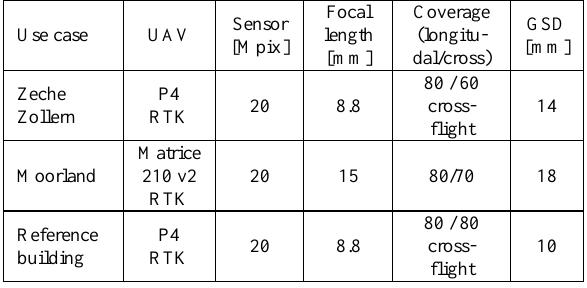
Table 1. Flight parameters of case studies